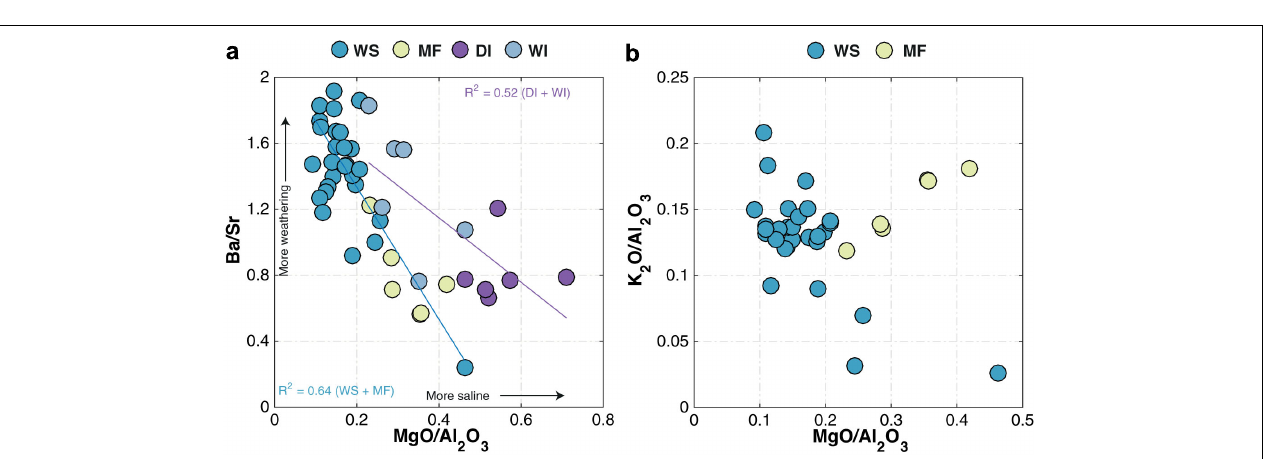
FIGURE 8 | REE patterns normalized to chondrite (McDonough and Sun, 1995) in MF (yellow-green), DI (purple), WI (light blue), and WS (blue) samples. WS, modern watershed; MF, modern mudflat; DI, late Quaternary dry interval; and WI, late Quaternary wet interval.